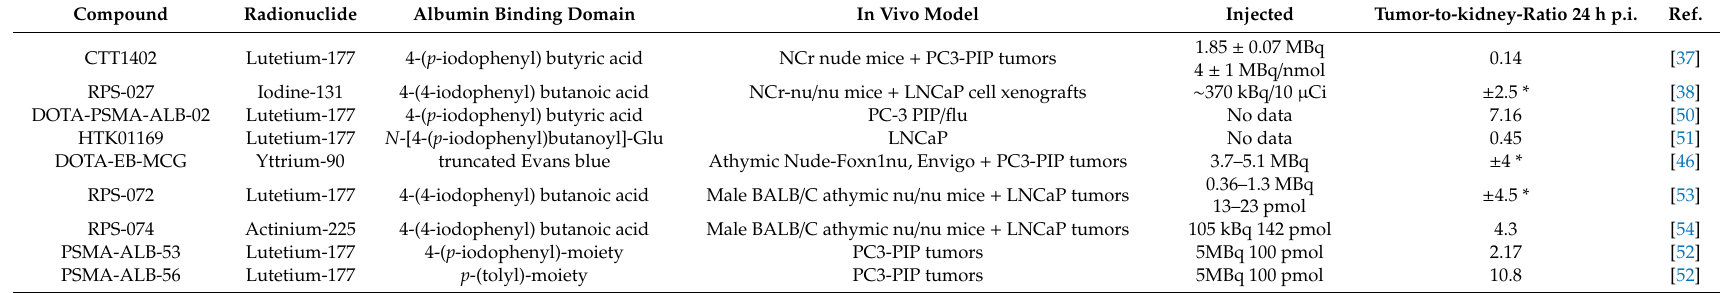
Table 2. Overview of PSMA-targeting small molecule inhibitors that have been conjugated with an albumin binding domain and their in vivo biodistribution data in mice. * Values had to be based on graphs rather than exact data as they were not present in the